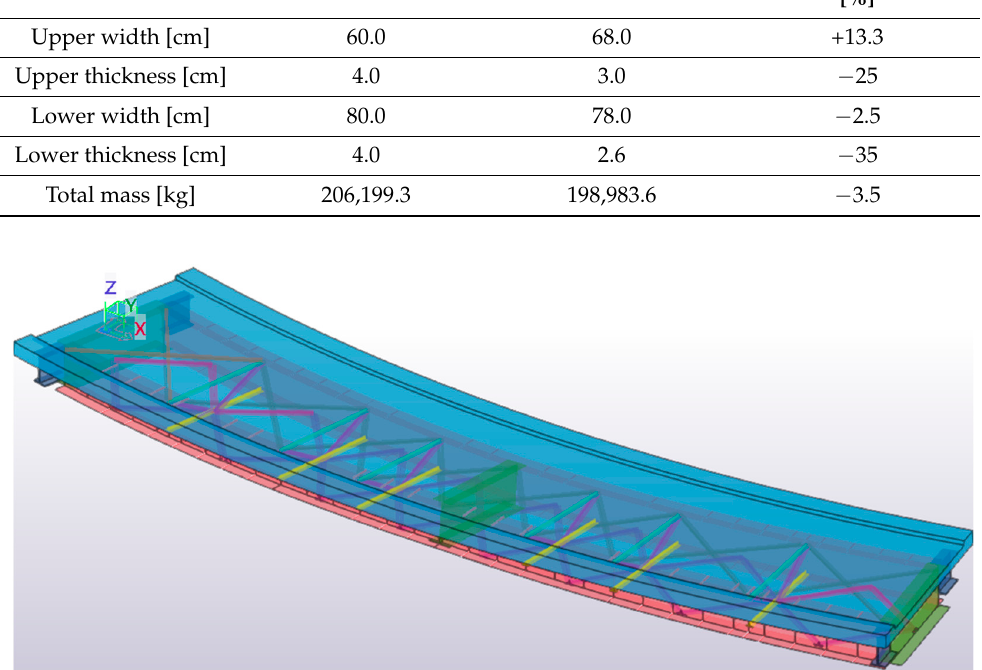
Figure 17. Optimized 3D model in Tekla Structures.